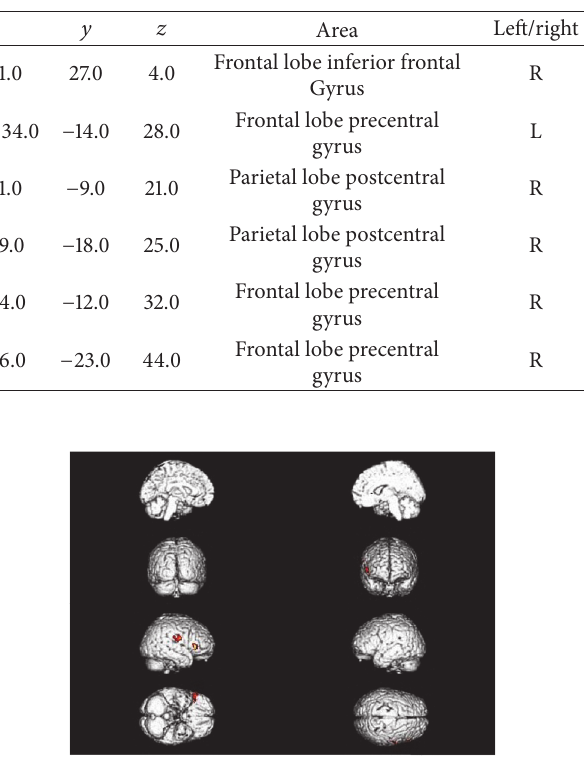
Table 2: Coordinates of Talairach’s Atlas ( 𝑥/𝑦/𝑧 axis) resulting from hypometabolic contrast SPM- 𝑡 analysis of typical Cogan’s syndrome group versus control group.